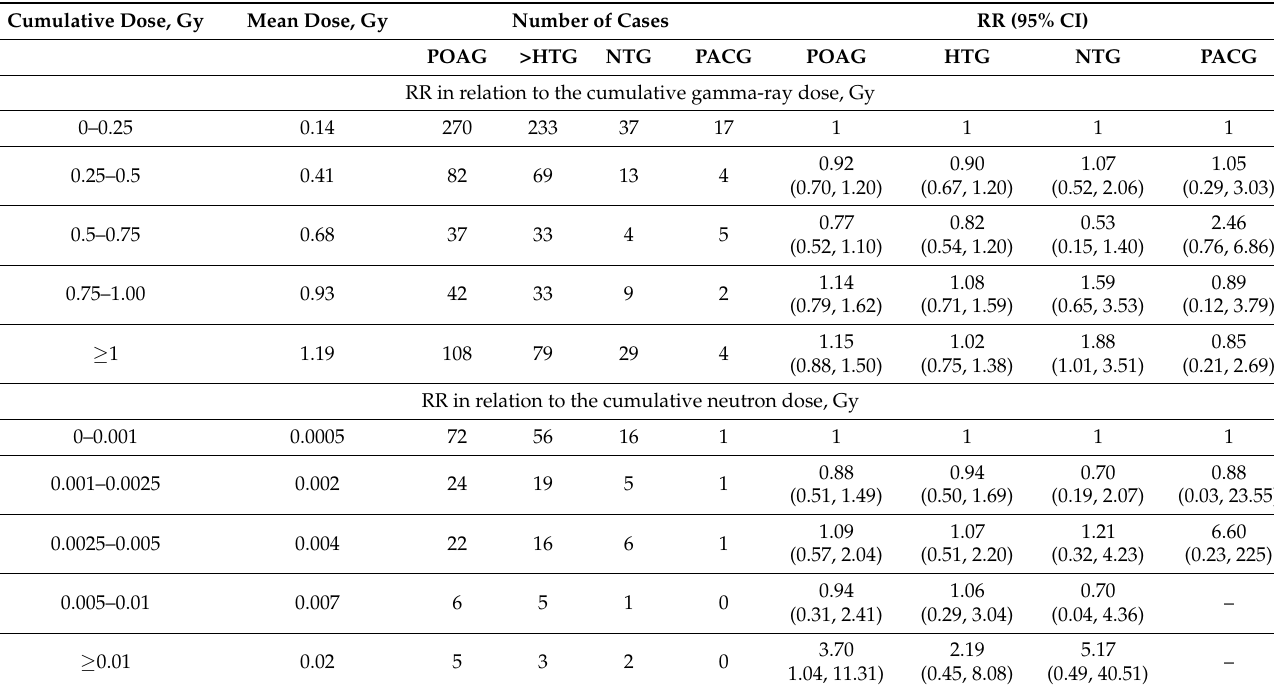
Table 3. Relative risks of various types of primary glaucoma for different categories of cumulative brain absorbed dose of gamma-ray and neutron exposure lagged for 5